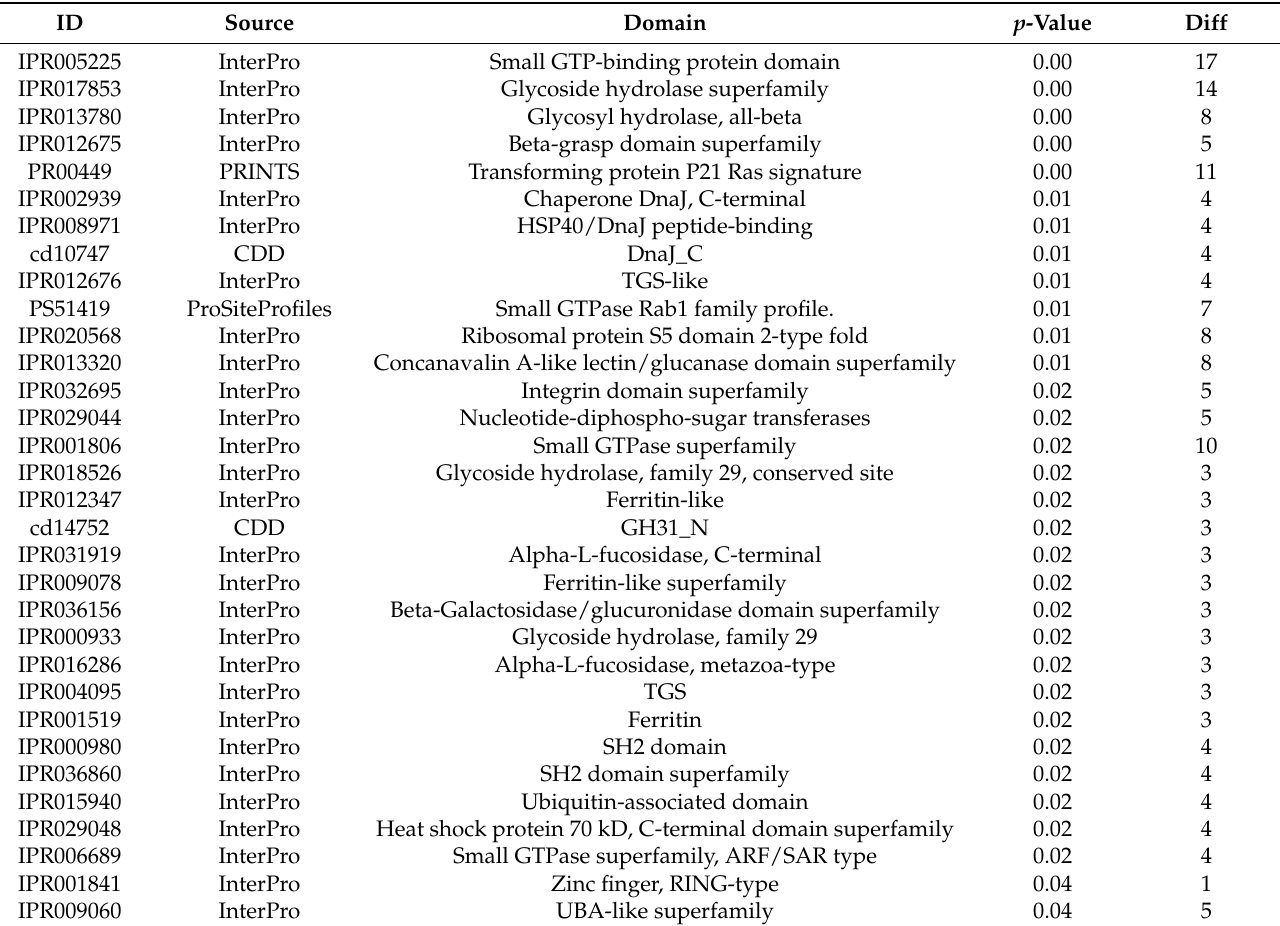
Table 5. Significant enrichment of protein domains ( p < 0.05) in the Chinese mitten crab infected with P. gregaria